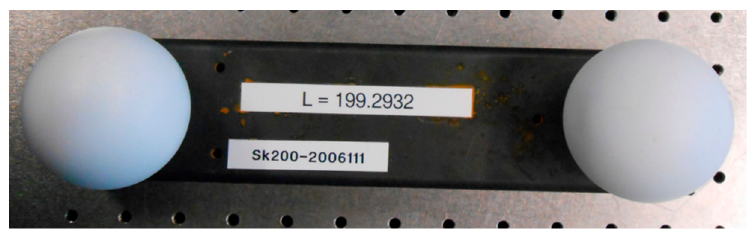
Figure 3. Specimen for calibration: calibrated ball bar.